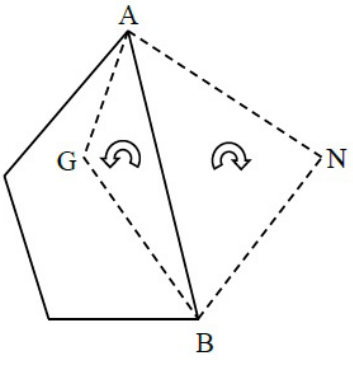
Figure 6: Inside or